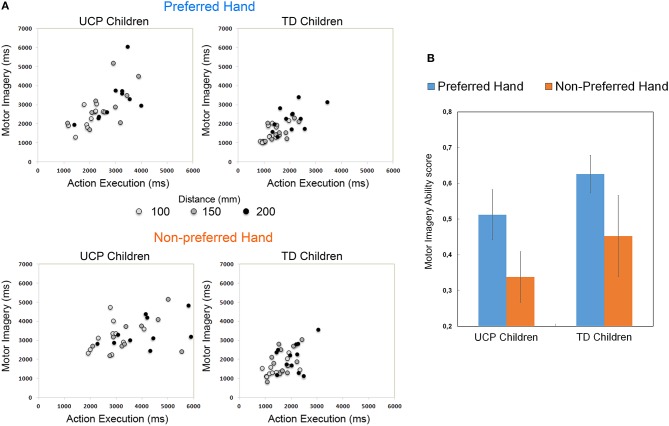
(A) Scatterplot showing correlations between movement durations (ms) in the Action Execution and Motor Imagery conditions performed by each group of participants, using the preferred and the non-preferred hand. The lighter dots represent the trials with the shortest distance, the darker dots those with the longest distance. (B) Histogram shows the Motor Imagery Ability (MIA) scores, calculated as correlation (Pearson coefficient) index between movement times under Action Execution and Motor Imagery conditions.